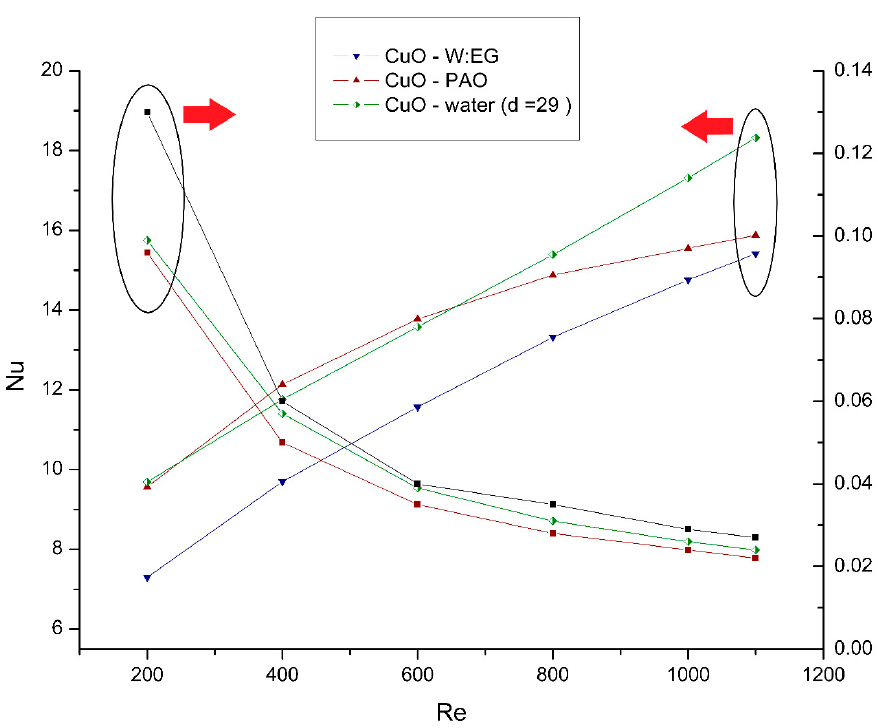
Figure 13. The e ff ect of base fluid material and Reynolds number on Nusselt number and Fanning Figure 13. The effect of base fluid material and Reynolds number on Nusselt number and Fanning friction friction factor.